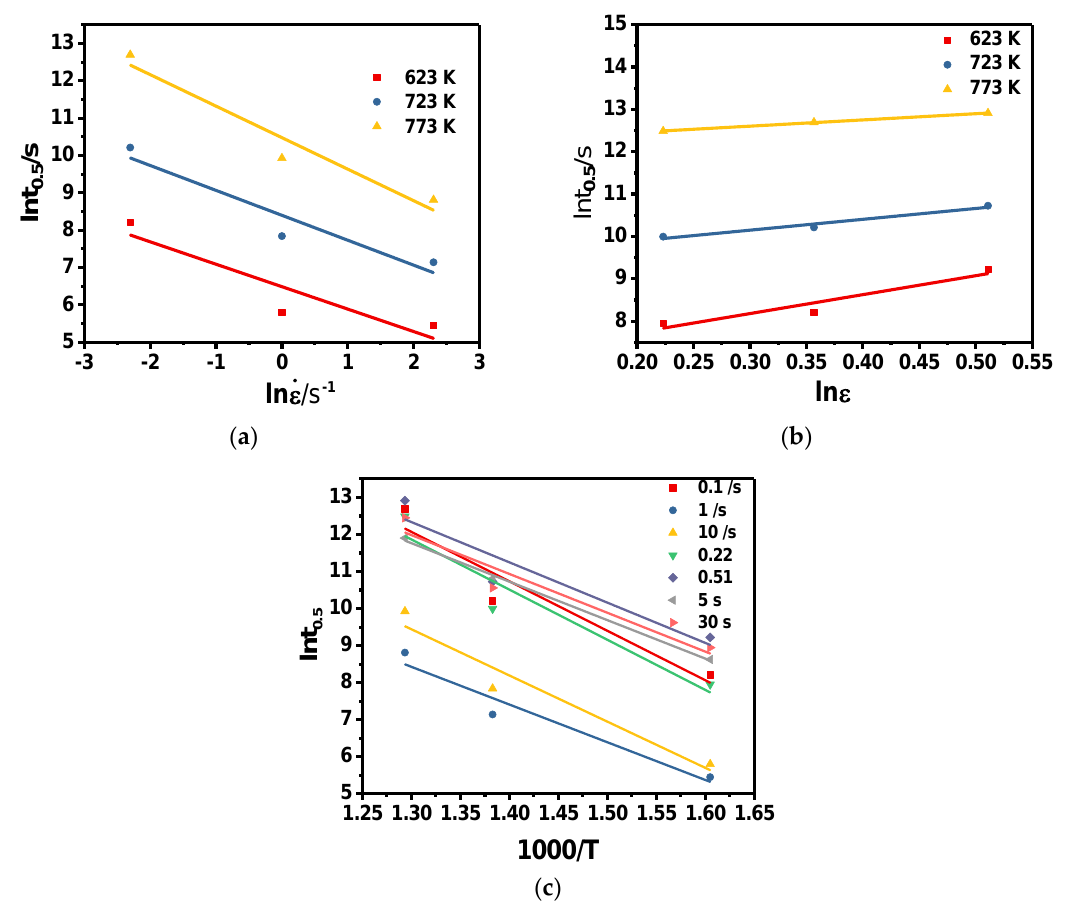
Figure 9. The relationship between lnt 0.5 and ( a ) ln Table 2. The values of the material parameters.